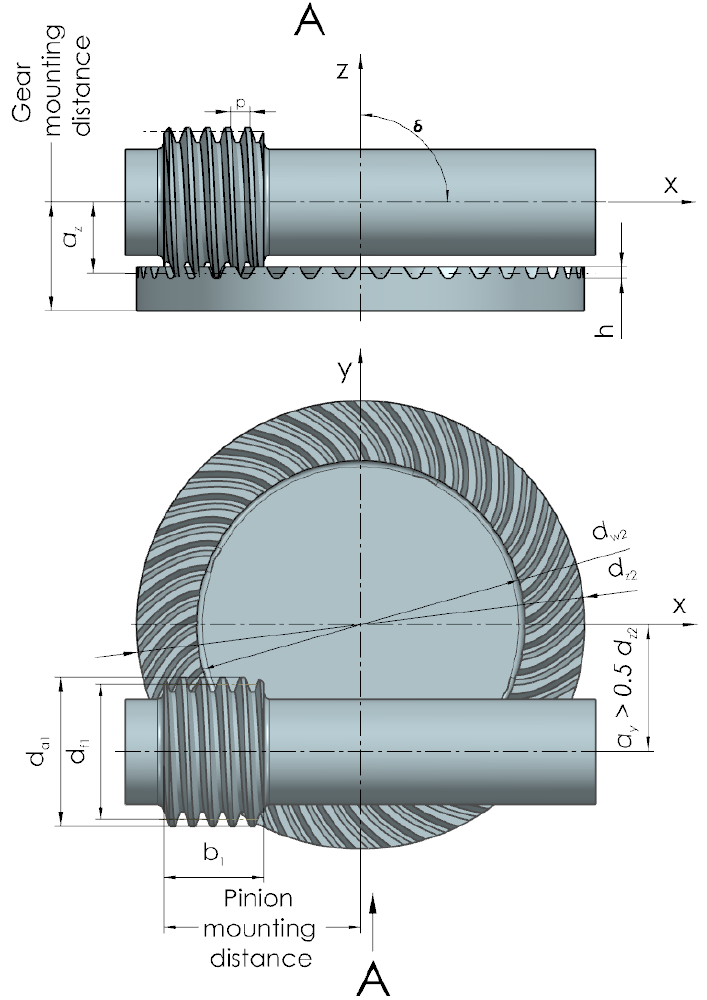
Figure 3. Basic dimensions of spiroid gear.